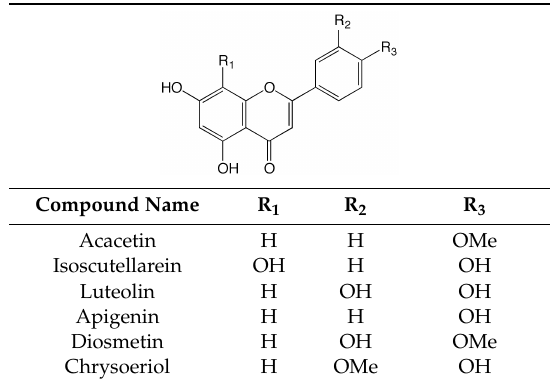
Table 2. Polymethoxyflavones occurring in Citrus spp.